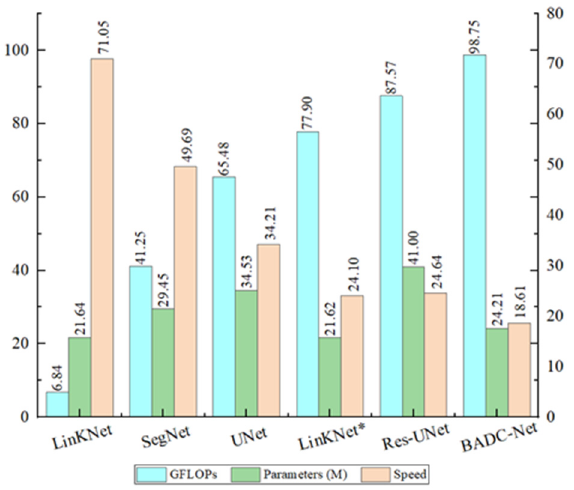
Figure 17. Comparison of GFLOPs and parameters for different methods. GFLOPs and parameters are computed from a tensor of dimension 1 × 3 × 256 × 256. The speed is tested with a batch size of 2, full precision (fp32), input resolution of 3 × 256 × 256, and measured in examples/second.